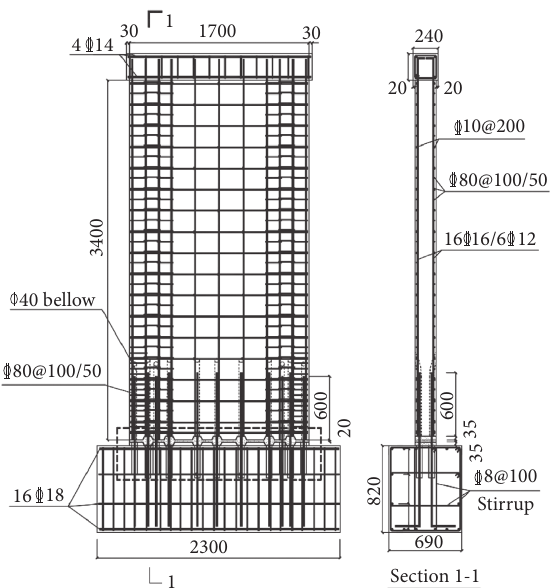
Figure 11: Dimensions (mm) and reinforcement configuration of the test